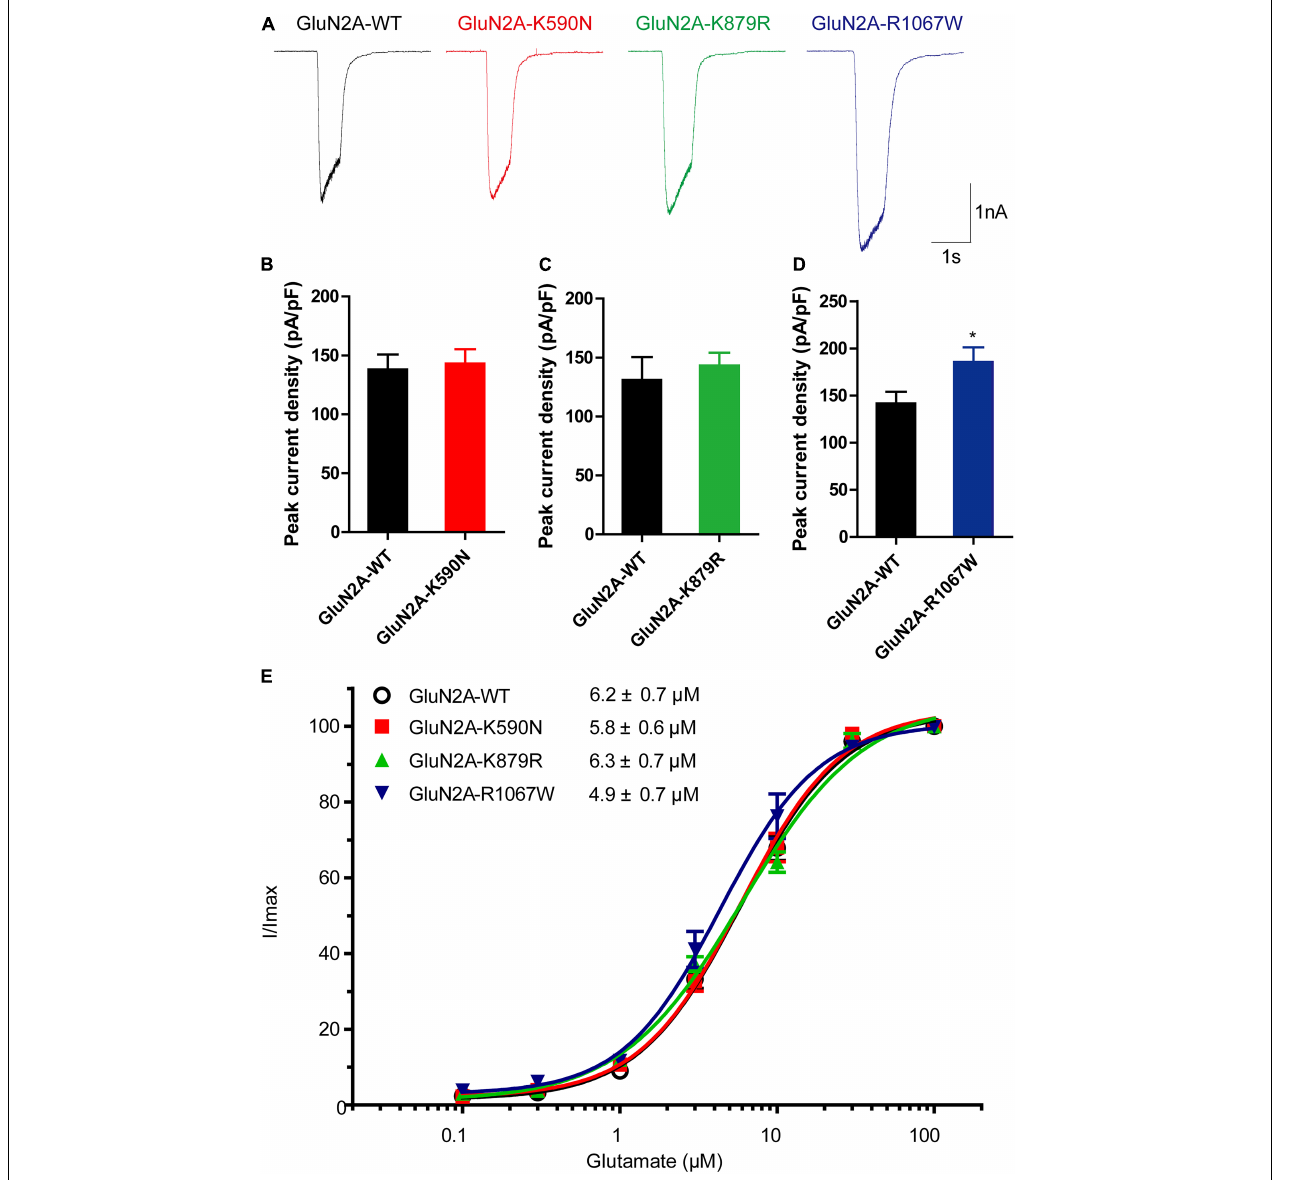
FIGURE 4 | Electrophysiological functional alterations of GluN2A-mutant NMDARs. (A) Representative current traces of GluN1/GluN2A-WT, GluN2A-K590N, GluN2A-K879R, and GluN2A-R1067W NMDARs evoked by 20 µ M glycine and 100 µ M glutamate (current scale bar, 1 nA; time scale bar, 2 s). (B) Quantitative analysis of whole-cell current density of GluN2A-WT ( n = 15) and GluN2A-K590N ( n = 13) NMDARs (Student’s t -test, p > 0.05). (C) Quantitative analysis of whole-cell current density GluN2A-WT ( n = 10) and GluN2A-K879R ( n = 12) NMDARs (Student’s t -test, p > 0.05). (D) Quantitative analysis of whole-cell current density of GluN2A-WT ( n = 12) and GluN2A-R1067W ( n = 13) NMDARs (Student’s t -test, * p < 0.05). (E) Glutamate concentration-response curves of GluN1/GluN2A-WT (black open circles, n = 6), GluN2A-K590N (red squares, n = 6), GluN2A-K879R (green triangles, n = 6), and GluN2A-R1067W (blue triangles, n = 6) NMDARs (One-way ANOVA with Bonferroni post hoc multiple comparison test, p > 0.05). NMDAR, N -methyl- D -aspartate